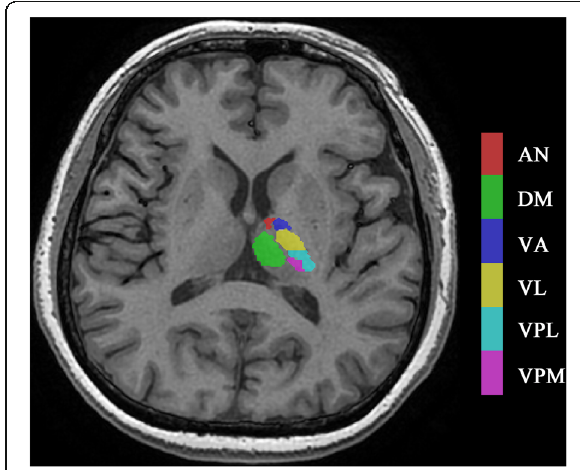
Fig. 2 The individual thalamic nuclei were generated by applying the inverse deformation with pullback strategy to the standard thalamic subnuclei. AN, anterior nucleus; DM, doromedial nucleus; VA, ventral anterior nucleus; VL, ventral lateral nucleus; VPL, ventral posterior lateral nucleus; VPM, ventral posterior medial nucleus